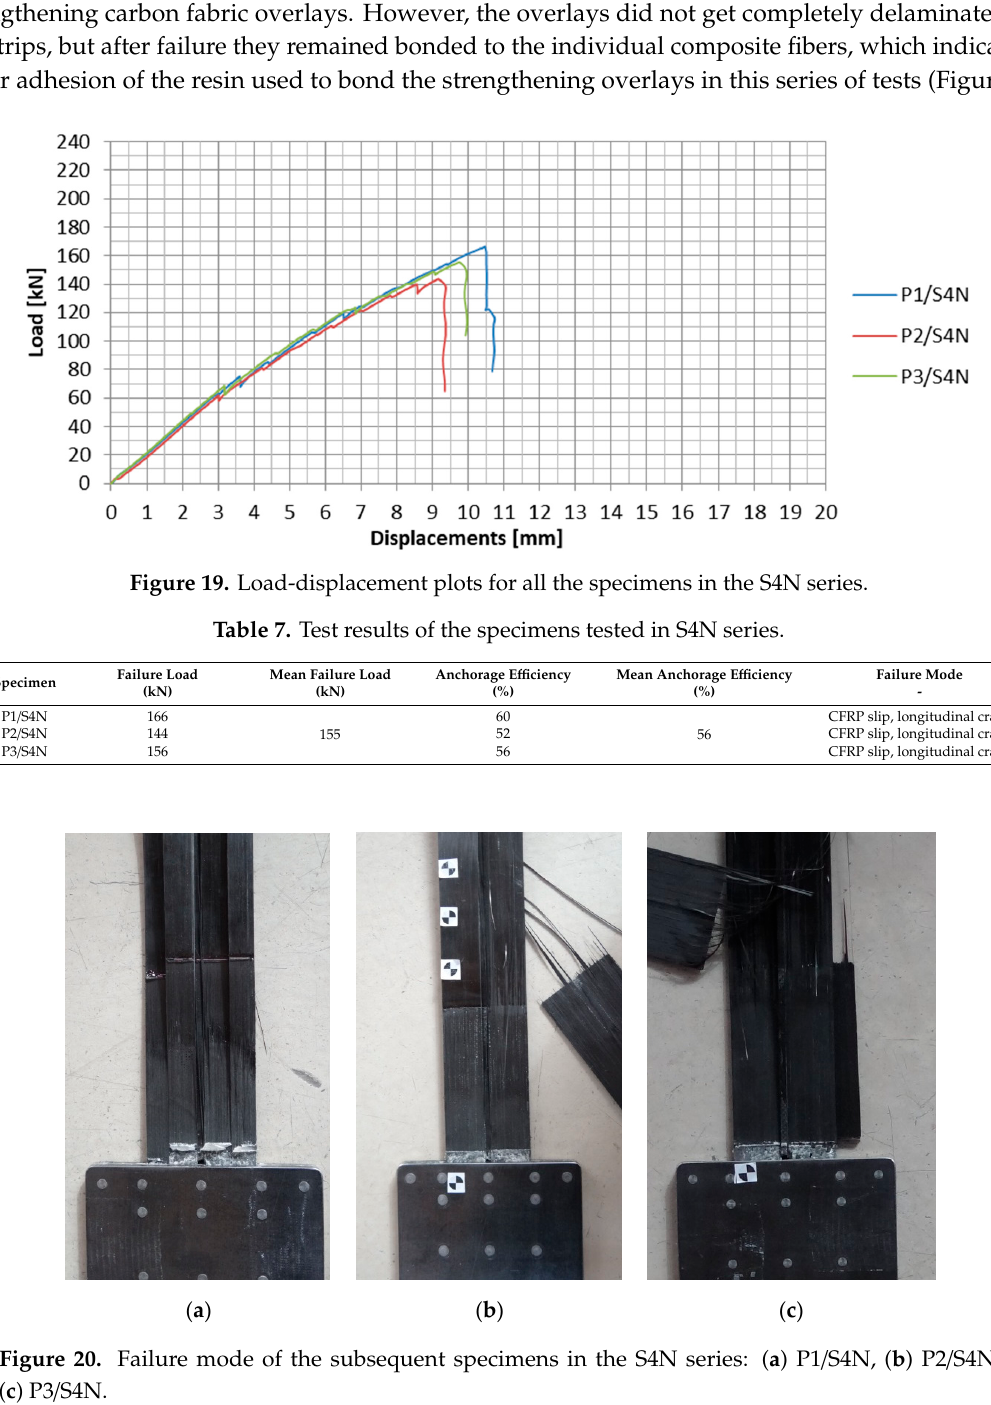
Figure 20. Failure mode of the subsequent specimens in the S4N series: ( a ) P1/S4N, ( b ) P2/S4N, ( c ) P3/S4N.